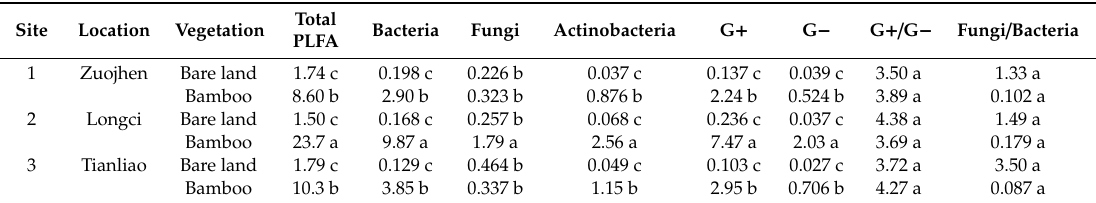
Table 1. Content of phospholipid acid biomarkers (nmol g − 1 soil) in the soils at di ff erent locations with and without bamboo